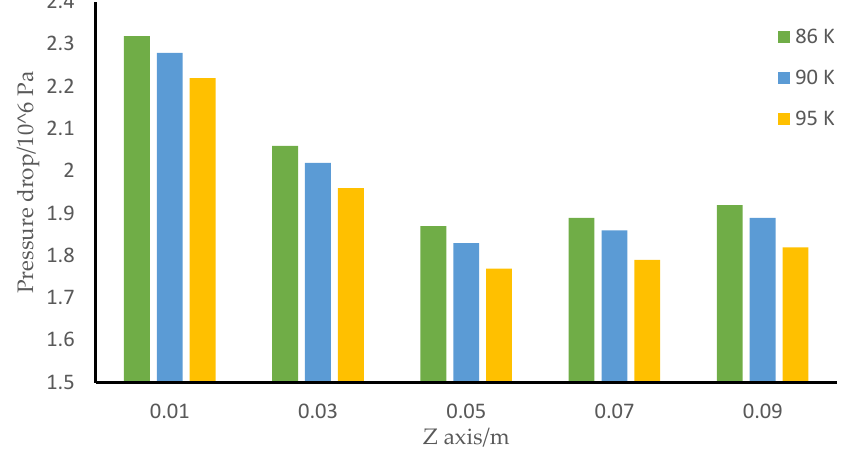
Figure 11. Pressure difference distribution of liquid oxygen at three different temperatures in the Zwart modified cavitation model.